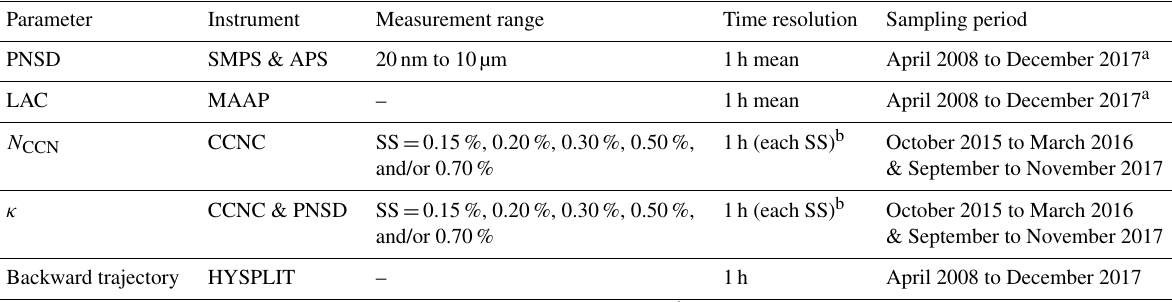
Table 1. Measured parameters, the respective instrumentations, and measurement periods. Parameter Instrument Measurement range Time resolution Sampling period PNSD SMPS & APS 20nm to 10µm 1h mean